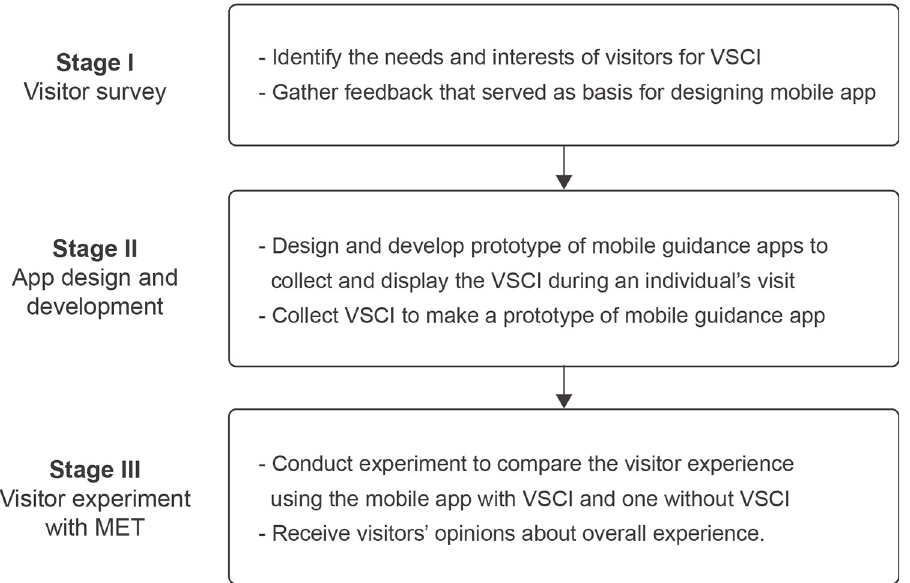
Fig 2. Overview of research methods. VSCI = visitor-based social contextual information; MET = mobile eye tracker.